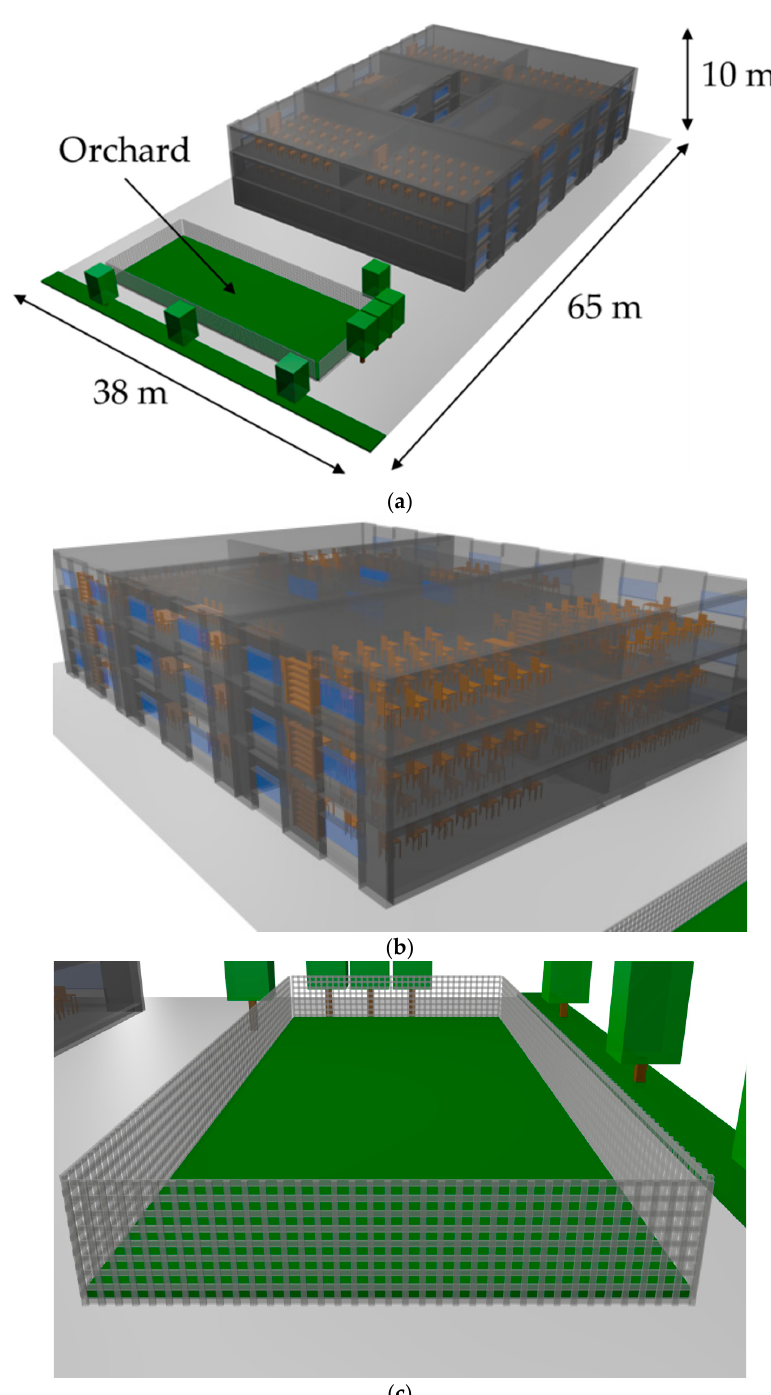
Figure 4. ( a ) Created scenario for the 3D Ray Launching simulations; ( b ) Detail of the building; ( c ) Detail of the metallic fence of the